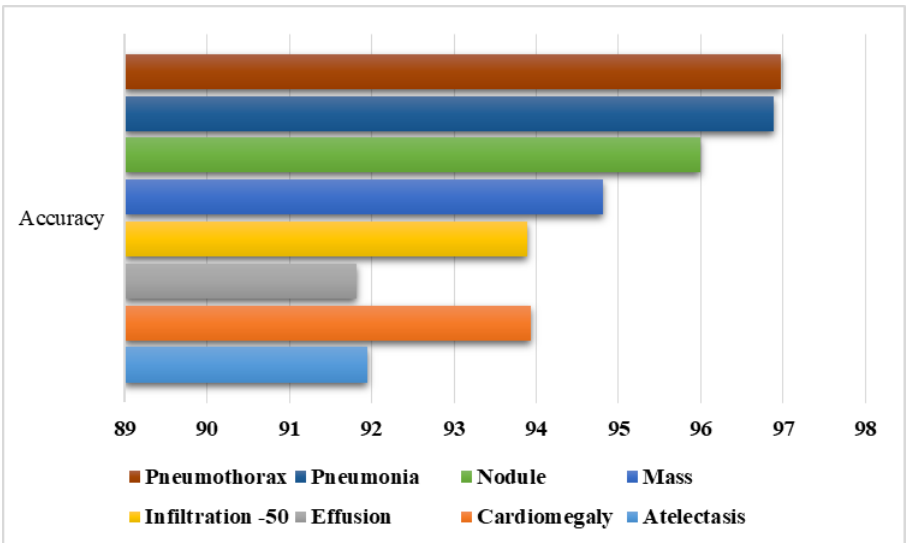
Figure 12. Category-wise accuracy results for the CXray-EffDet model .